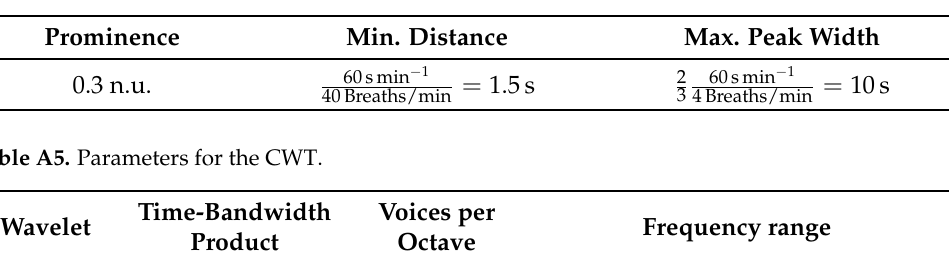
Table A4. Parameters for the Peak detection algorithm.